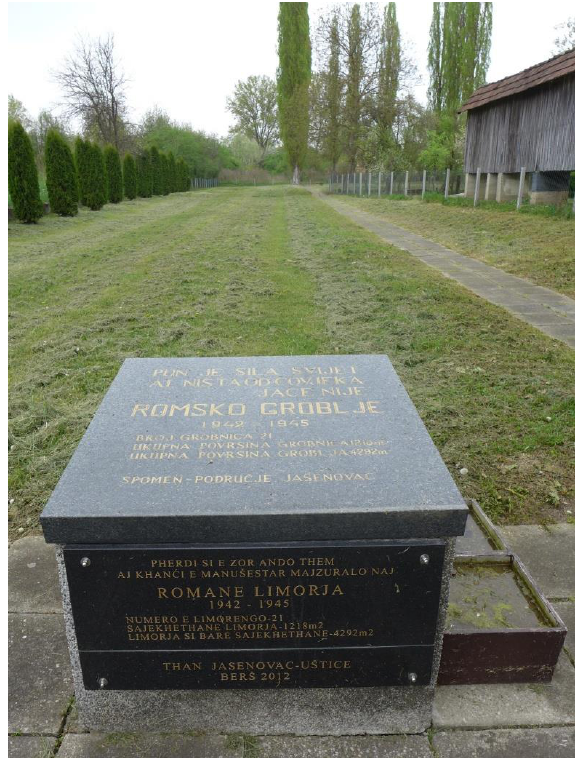
Figure 3. Memorial at the site of the former “Gypsy camp” Uštica, part of the Jasenovac Memorial Site,